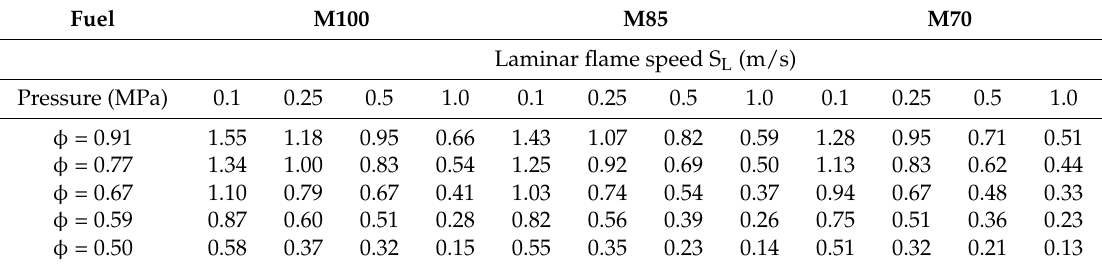
φ = 0.59 1896 φ = 0.50 Table 6. Laminar flame speed at elevated pressures and T sub = 630 K (SanDiego). Fuel M100 M85 M70 Laminar flame speed S L (m/s) Pressure (MPa) 0.1